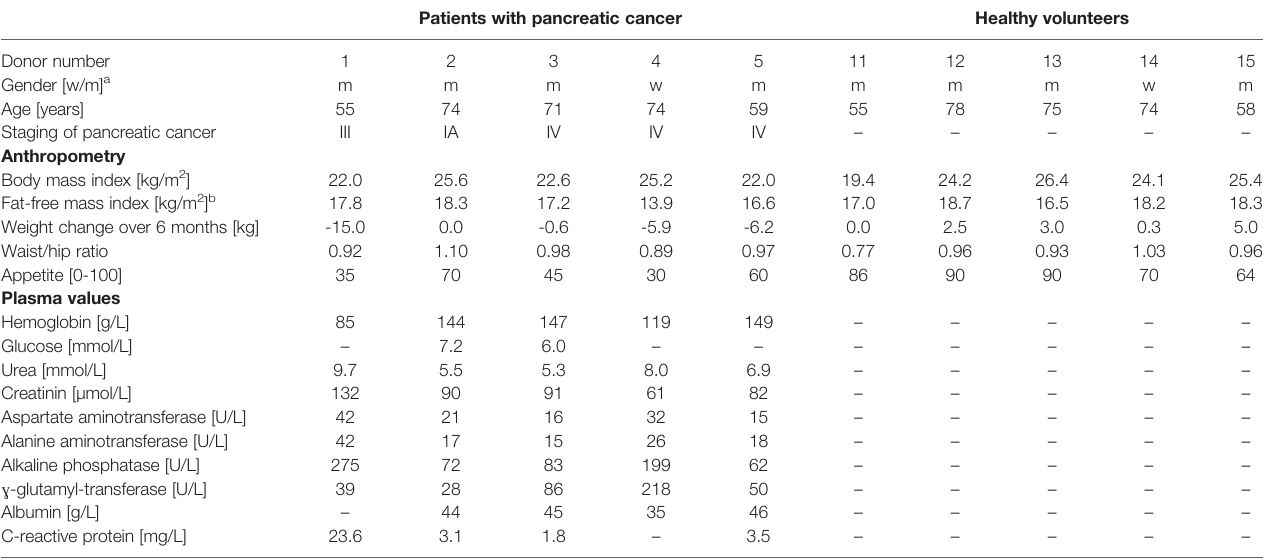
TABLE 1 | Baseline characteristics of PC patients and healthy volunteers.